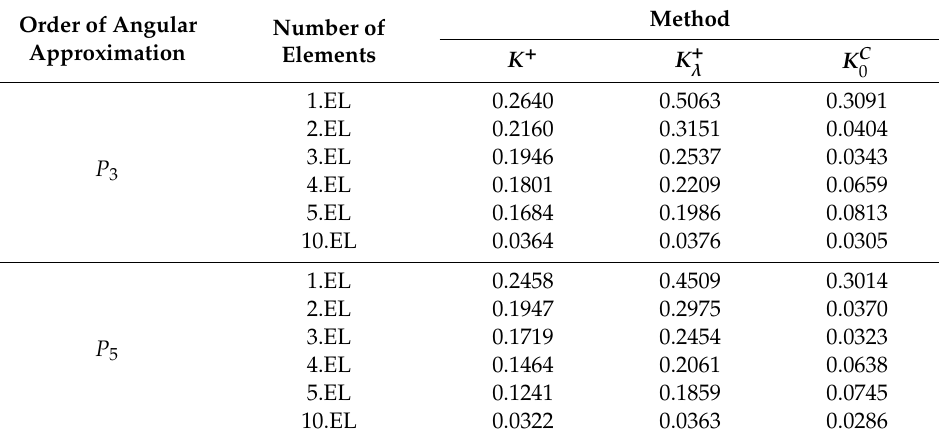
Table 2. Relative errors for P 3 , P 5 approximations with a set of elements for region 1.